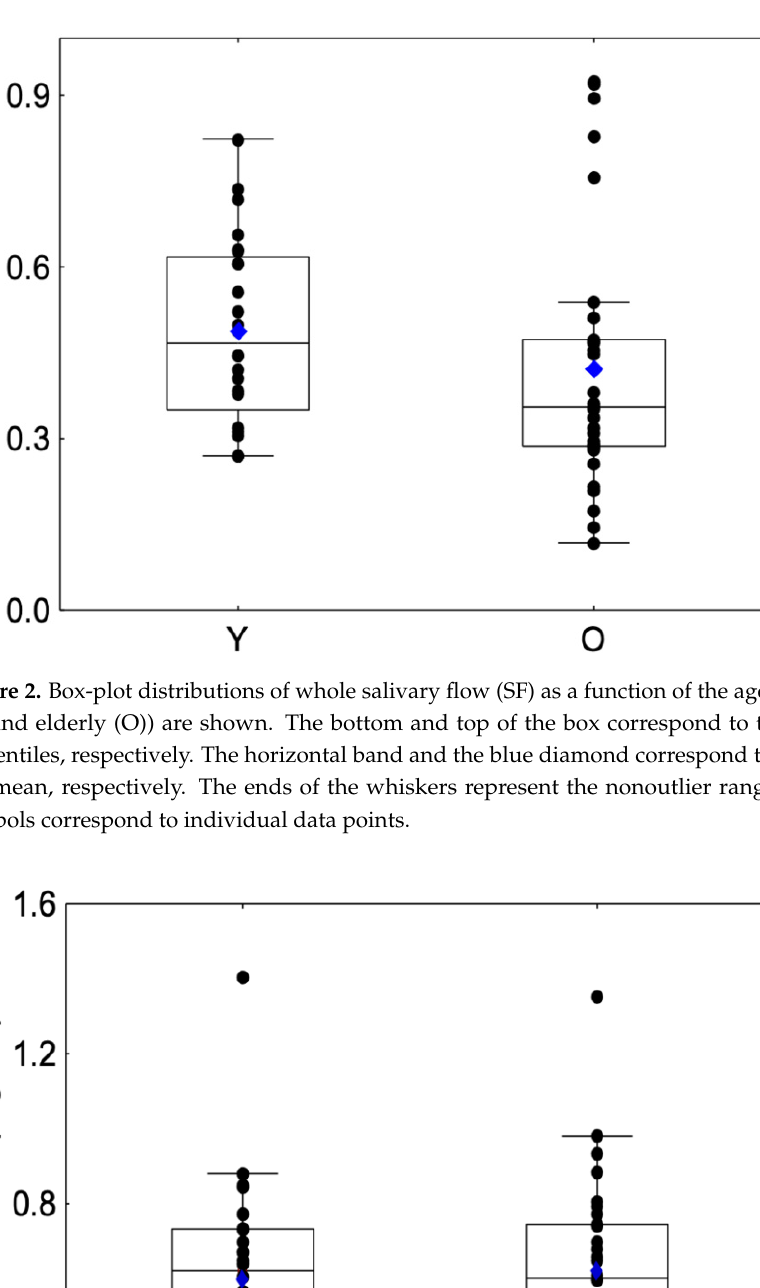
Figure 3. Box-plot distributions of salivary protein amount as a function of the age category (young (Y) and elderly (O)) are shown. The bottom and top of the box correspond to the 25th and 75th percentiles, respectively. The horizontal band and the blue diamond correspond to the median and the mean, respectively. The ends of the whiskers represent the nonoutlier range. The black dot symbols correspond to individual data